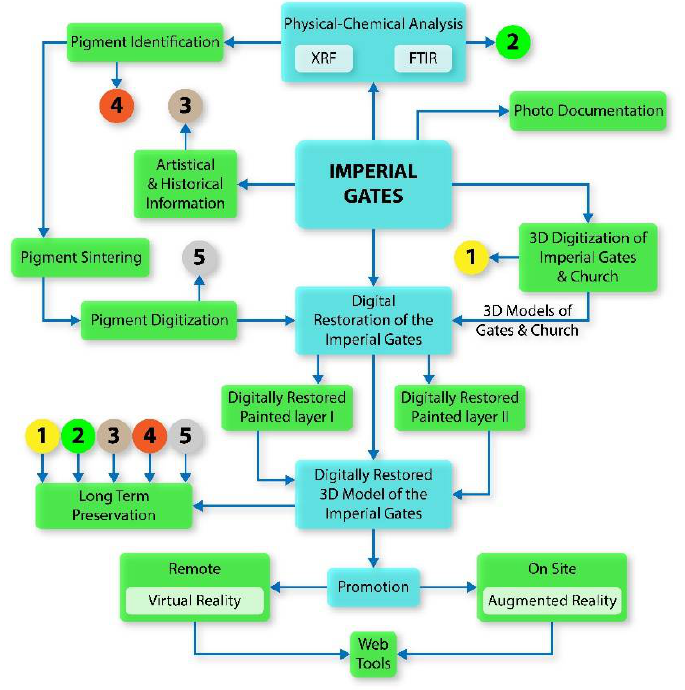
Figure 3. Methodology. Figure 3.